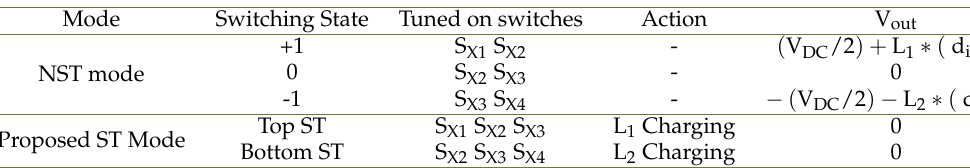
Table 3. Switching table of Z source NPC-MLI